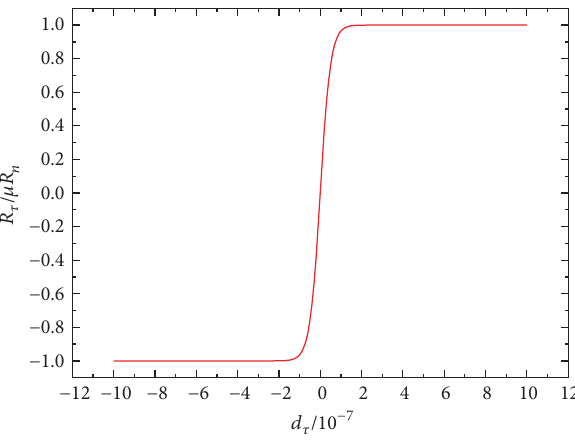
Figure 5: Approximated function curve of the step